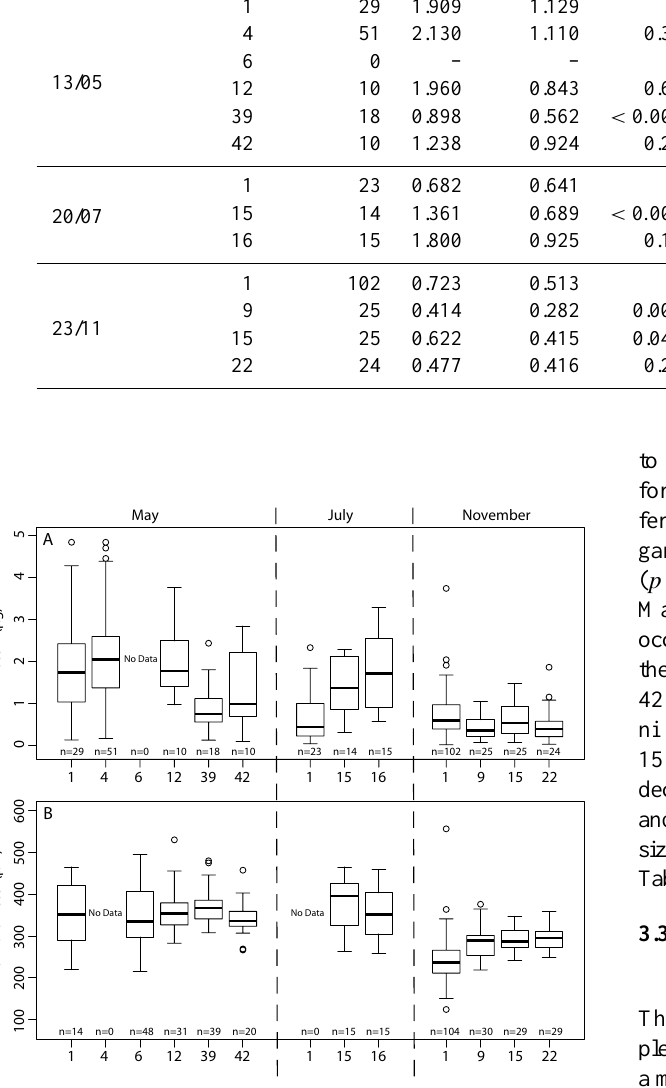
Fig. 2. (A) Protein content of crushed A. tepida of the three sam- pling campaigns in May, July, and November 2010, and for all cul- tivation intervals of 1 to 42days ( n = 373). (B) Development of the minimum diameter of non-crushed A. tepida of the different sam- pling campaigns and cultivation intervals. Individuals represented here are all the non-crushed individuals, i.e. the specimens treated with an osmotic shock, ultrasonication for 2s, and 10% NaOH ( n =